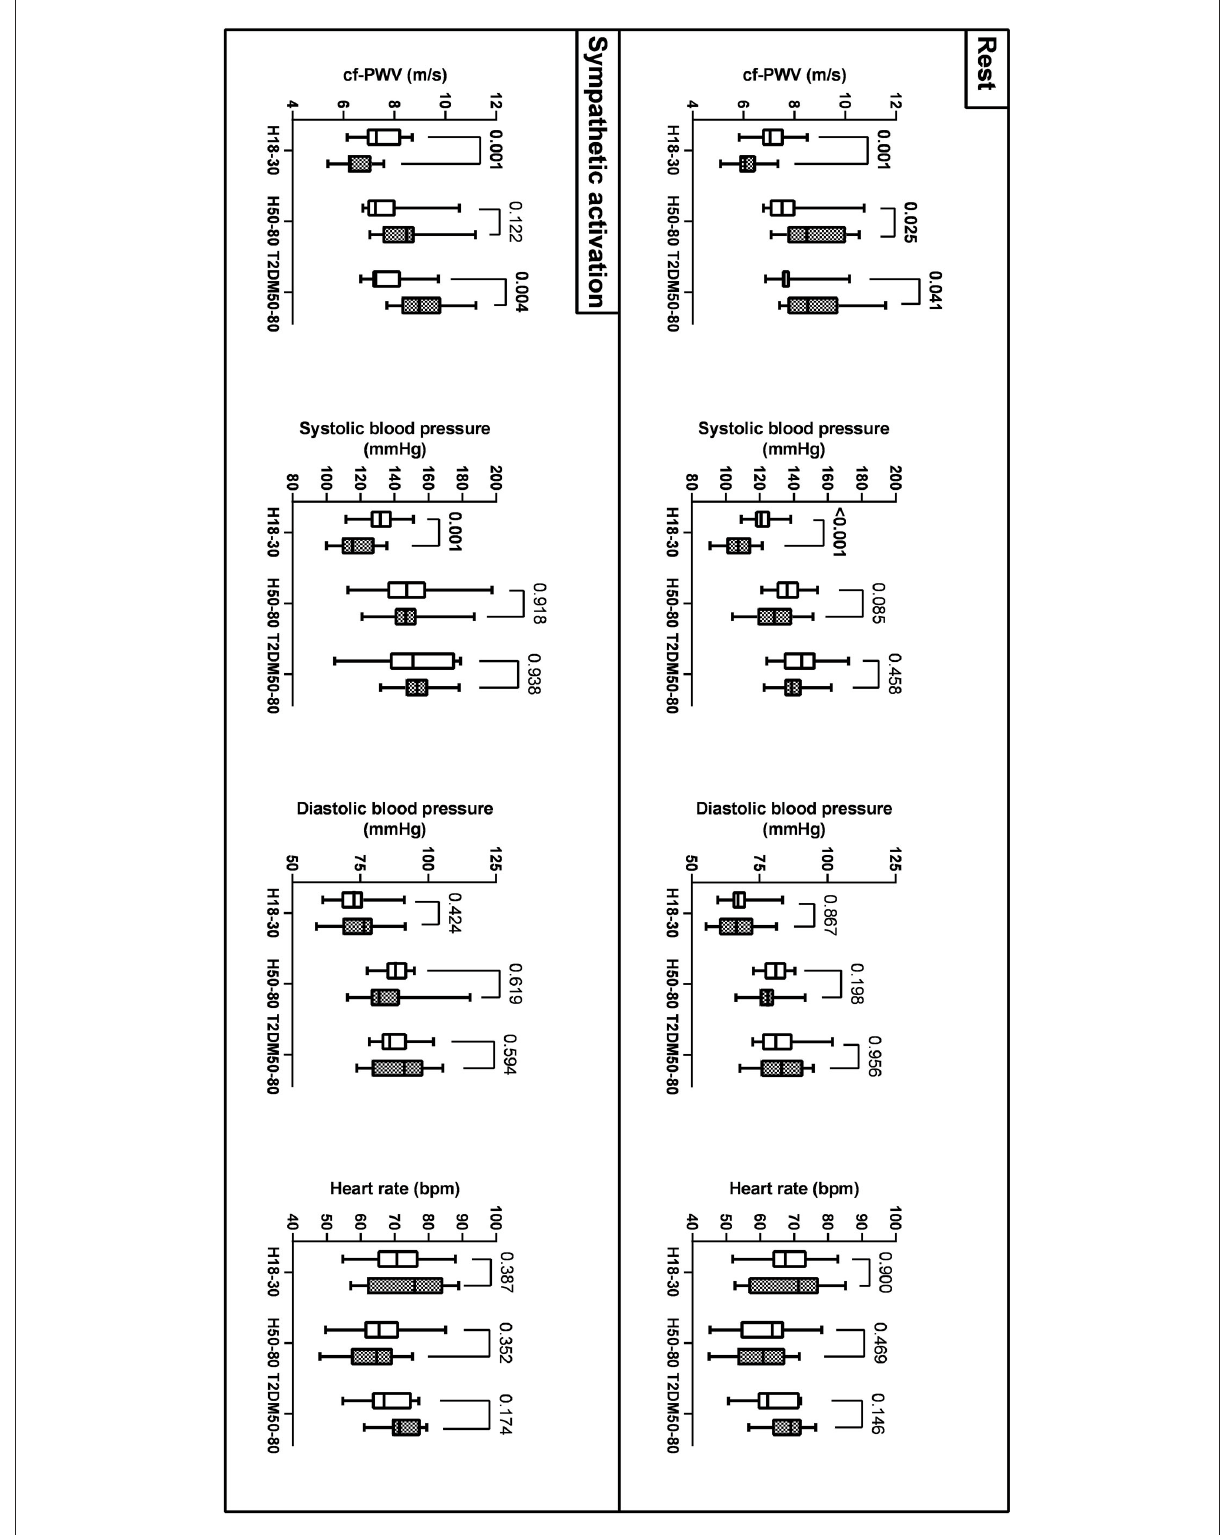
FIGURE2 Sex differences (men: empty bars; women: filled bars) in cf-PWV, systolic AP, diastolic AP, and HR across the three groups at rest and during sympathetic activation (mean, Q1/4, Q3/4, and minimum and maximum